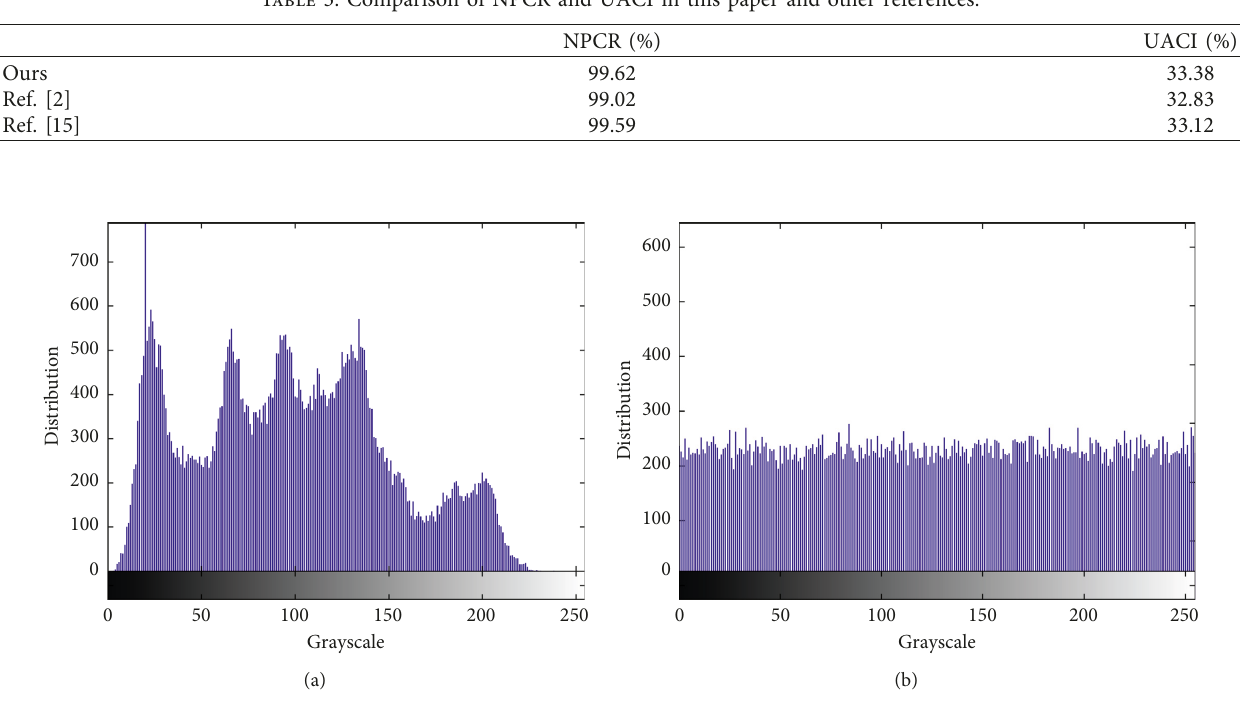
Figure 17: Histogram of (a) plain image and (b) encrypted image.